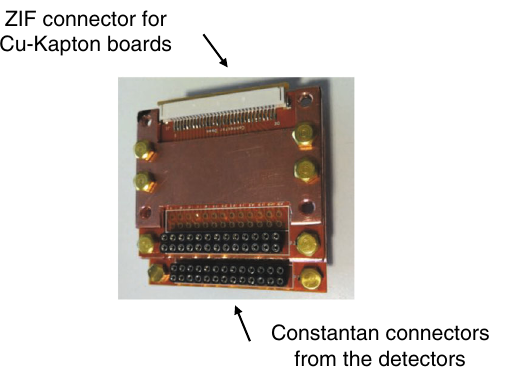
Fig. 17 Junction boards on the MC for connecting the NbTi-NOMEX cables to the constantan wires from the detectors